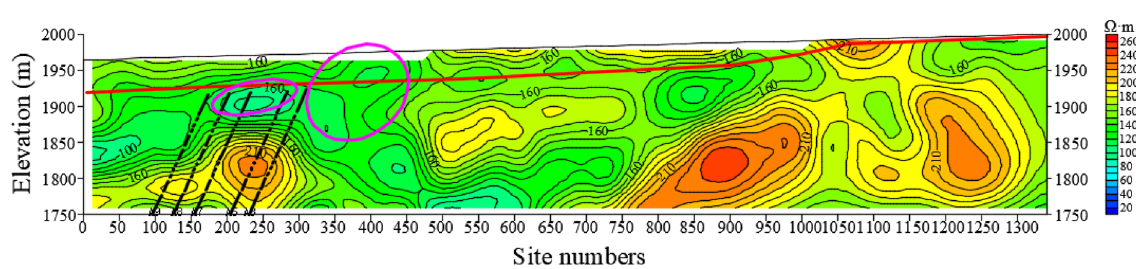
Figure 12. The resistivity profile of the TEM of